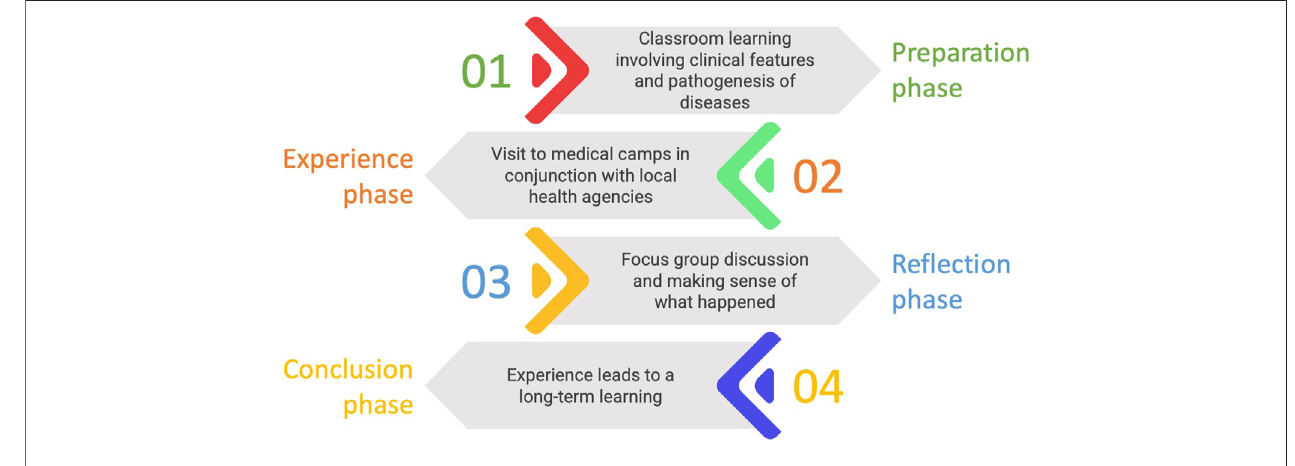
FIGURE 1 | Theoretical framework based on Kolb ’ s learning cycle.